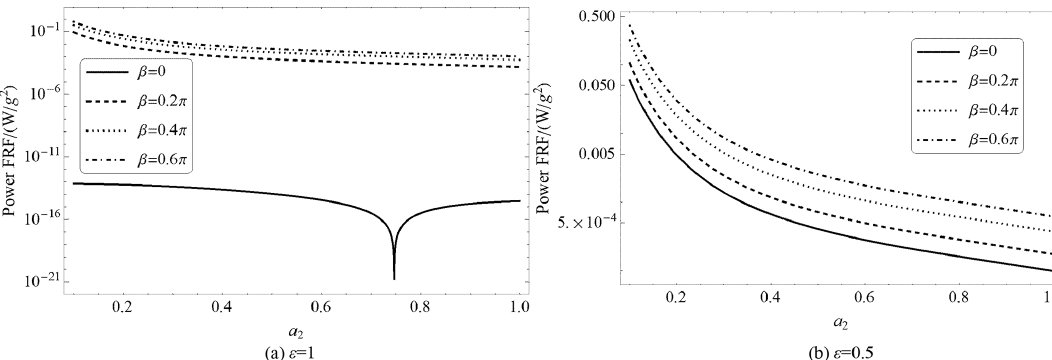
Figure 8. Power FRF ( R = 10 5 (cid:127) and (cid:36) =